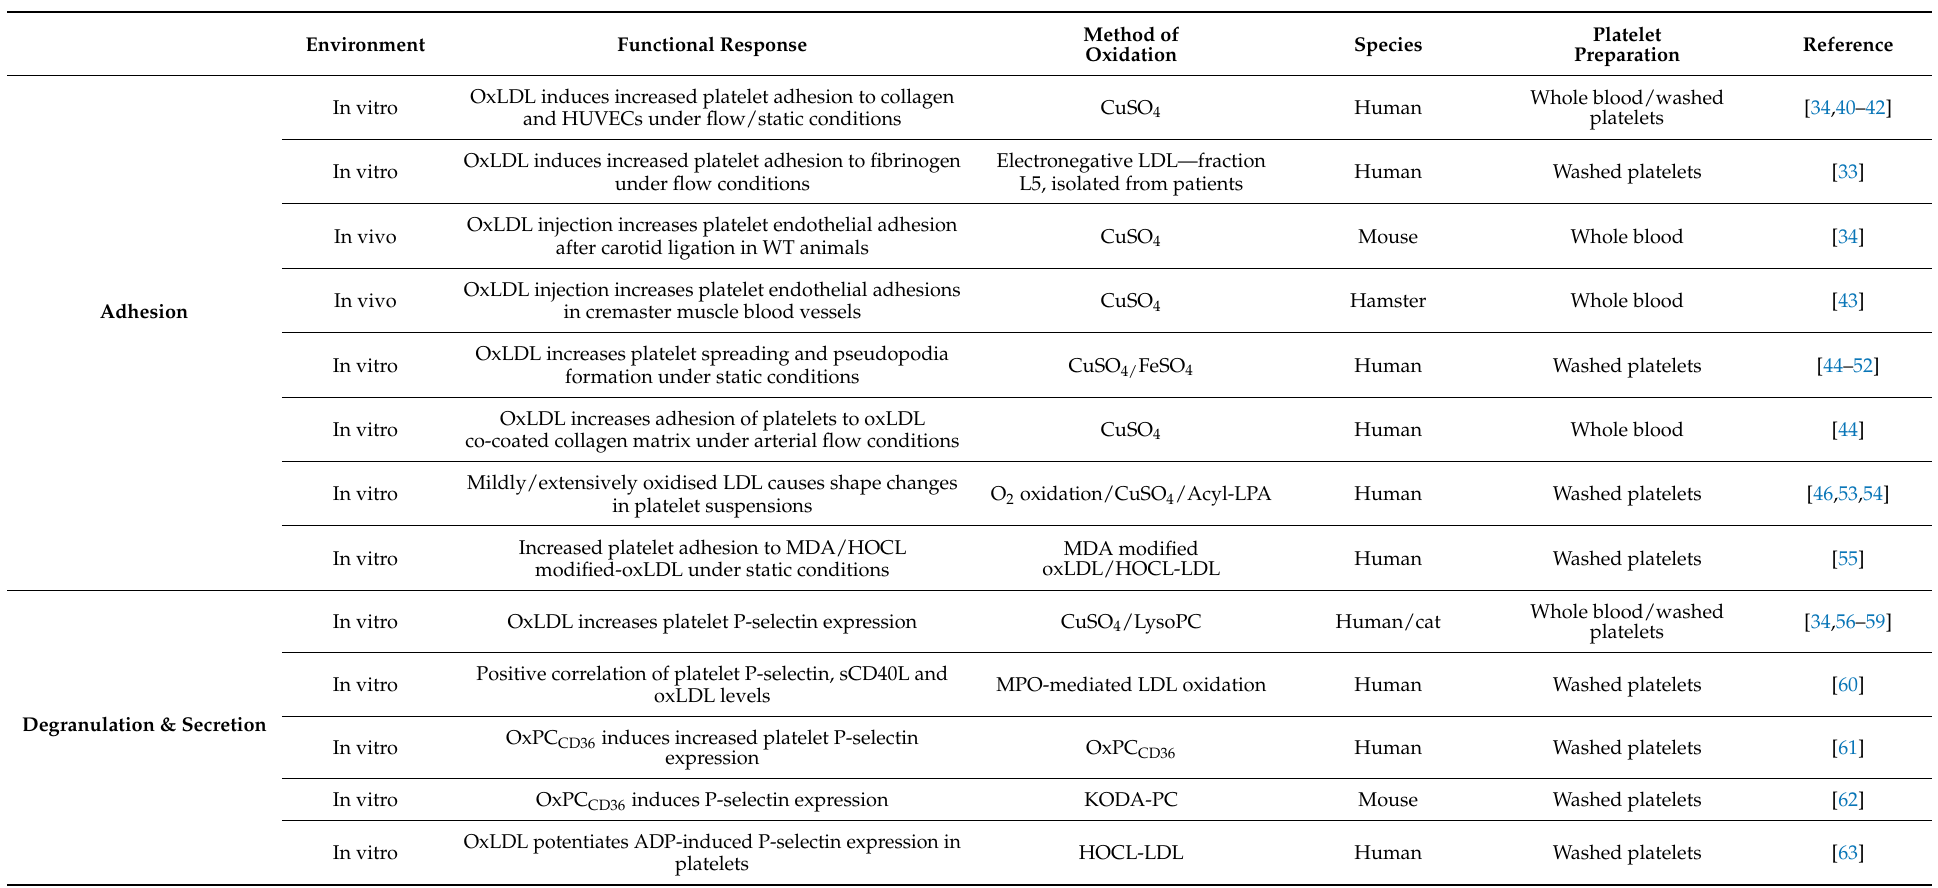
Table 1. Functional effects of oxLDL and derivates on platelets. OxLDL—oxidised LDL; CuSO 4 —copper (II) sulphate; HUVEC—human umbilical vein endothelial cells; WT—wildtype; Acyl-LPA—acylated lysophosphatidic acid; FeSO 4 —iron (II) sulphate; MDA—malondialdehyde; HOCL—hypochlorus acid; Lyso-PC— lysophosphatidylcholine; MPO—myeloperoxidase; oxPC CD36 —oxidised phosphocholine specific for CD36; ADP—adenosine diphosphate; METS-LDL—metabolic syndrome-associated LDL; DMII-LDL—diabetes mellitus II-associated LDL; SIN-1-LDL—3-(N-morpholino)sydnonimine-LDL; Ac-LDL—acetylated LDL;